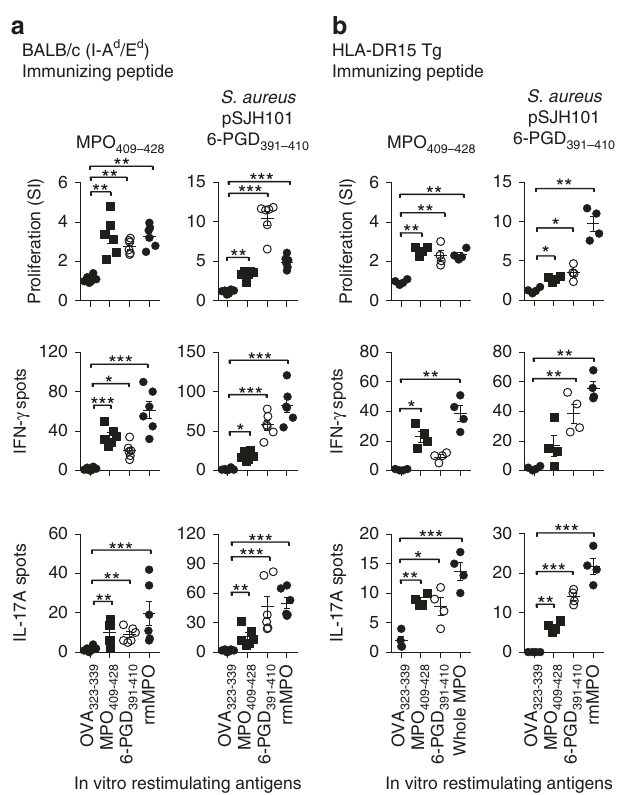
Fig. 10 Anti-MPO T-cell responses in other S. aureus pSJH101 6PGD 391 – 410 immunized mouse strains. a BALB/c (I-A d /I-E d expressing, n = 6) and b HLA-DR15 transgenic (Tg, n = 4) mice were immunized with MPO 409 – 428 (positive control) and pSJH101 6PGD 391 – 410 , then T-cell responses measured ex vivo to either OVA 323 – 339 (negative control), MPO 409 – 428 , 6PGD 391 – 410 , and recombinant mouse MPO using [ 3 H]-thymidine proliferation assays (top row), and ELISOPT for IFN- γ (middle row) or IL- 17A (bottom row). Each dot represents the response from an individual mouse, error bars represents the mean ± s.e.m. Data are representative of two independent experiments. * P < 0.05, ** P < 0.01, *** P < 0.001 by Kruskal – Wallis test. Source data are provided as a Source Data fi